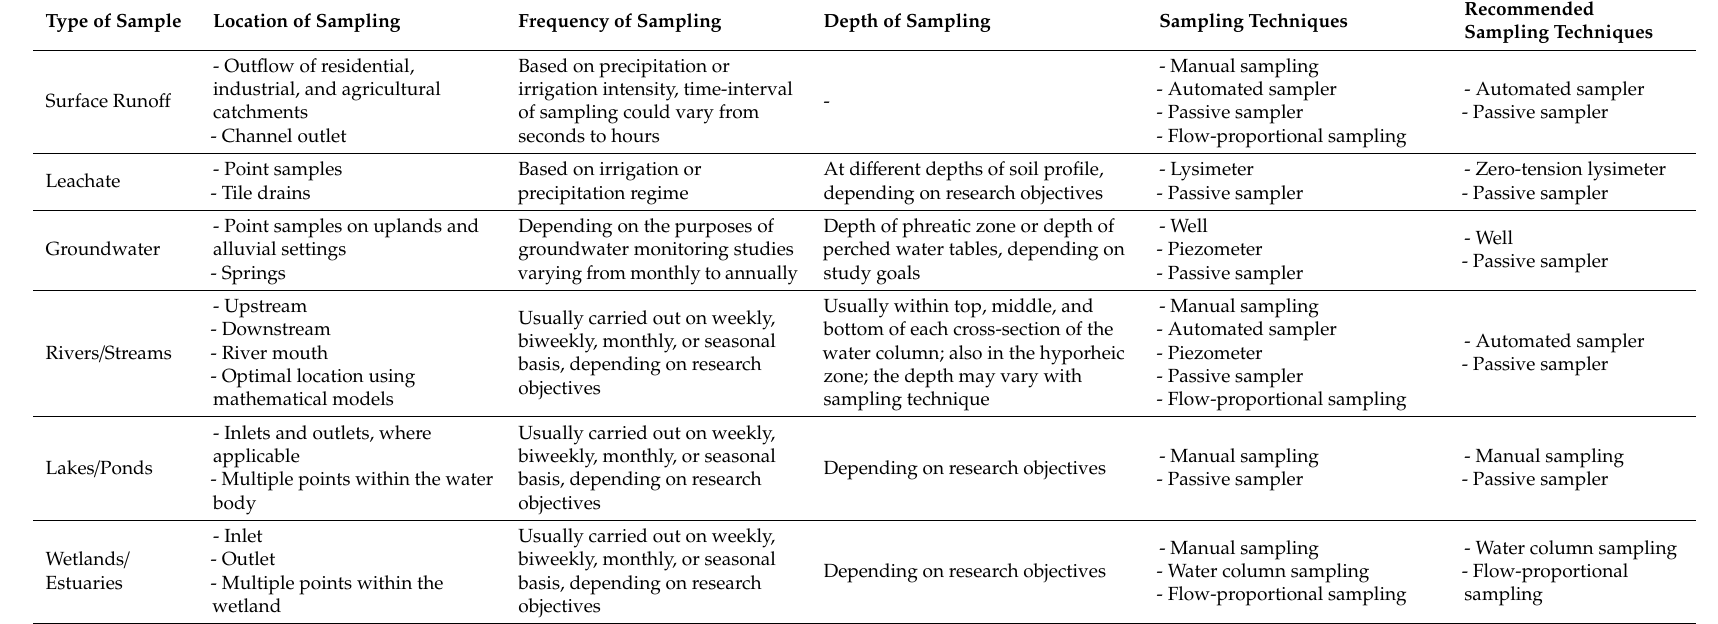
Table 1. The most common sampling techniques to collect di ff erent aquatic